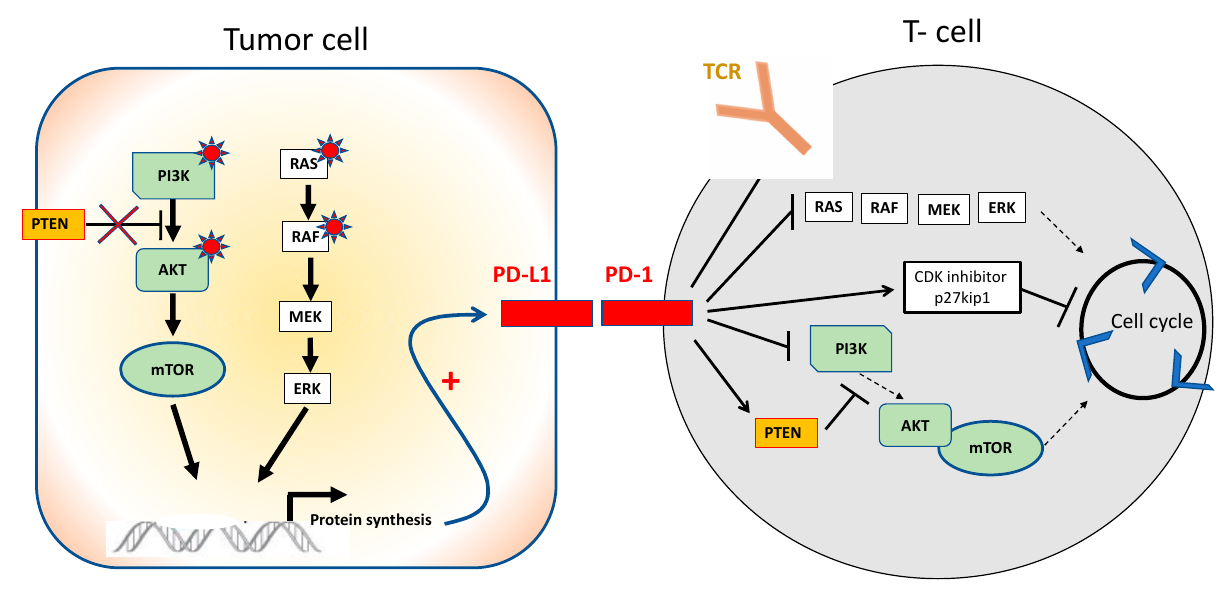
Figure 2. In tumor cells, oncogenic activation of PI3K–Akt–mTOR and MAPK and loss of PTEN induces overexpression of PD-L1 via stimulation of protein synthesis. In T-cells, PD-1 expression inhibits downstream activation of the PI3K–Akt–mTOR and MAPK pathways, inhibits cell cycle progression and negatively regulates T-cell receptor activity.